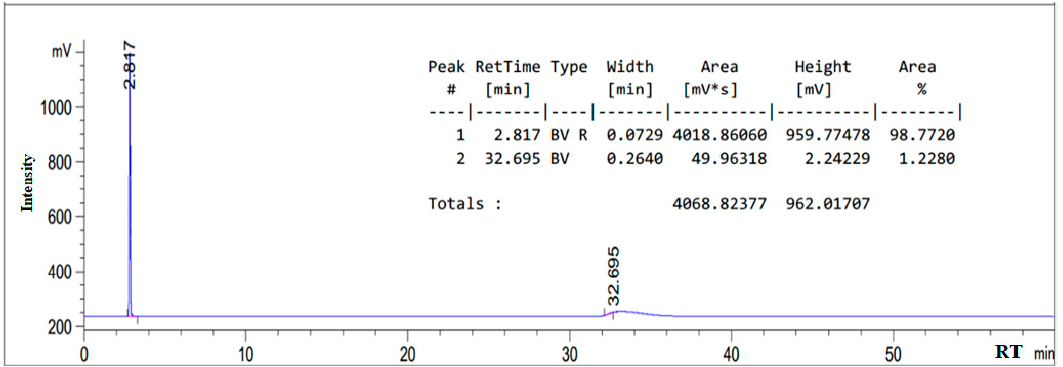
Figure A2. HPLC chromatogram for 0.5 wt.% N,N trimethylene dimethyl amine.